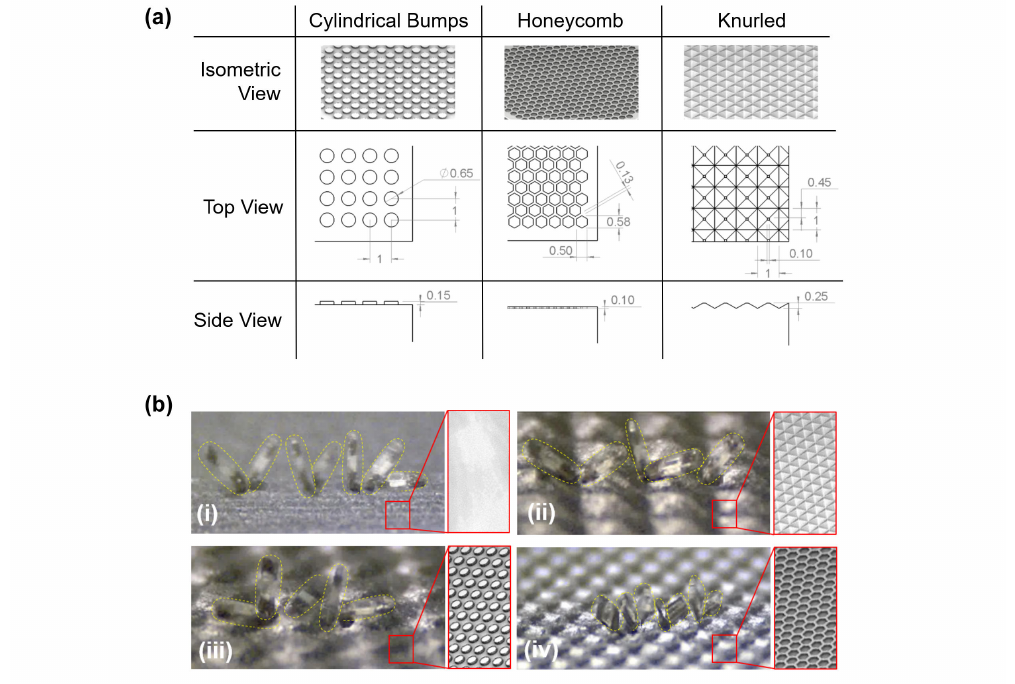
Figure 11. ( a ) Dimensions of the terrain geometries explored (all dimensions in millimeters); ( b ) µ TUM traveling over different terrains in dry environments, with a 10 mT field strength @ 0.5 Hz. (i) Flat paper; (ii) cylindrical bumps; (ii) knurled surface; (iv) honeycomb terrain (side-ways tumbling mode). Please see Supplemental Video S5 for video footage of these